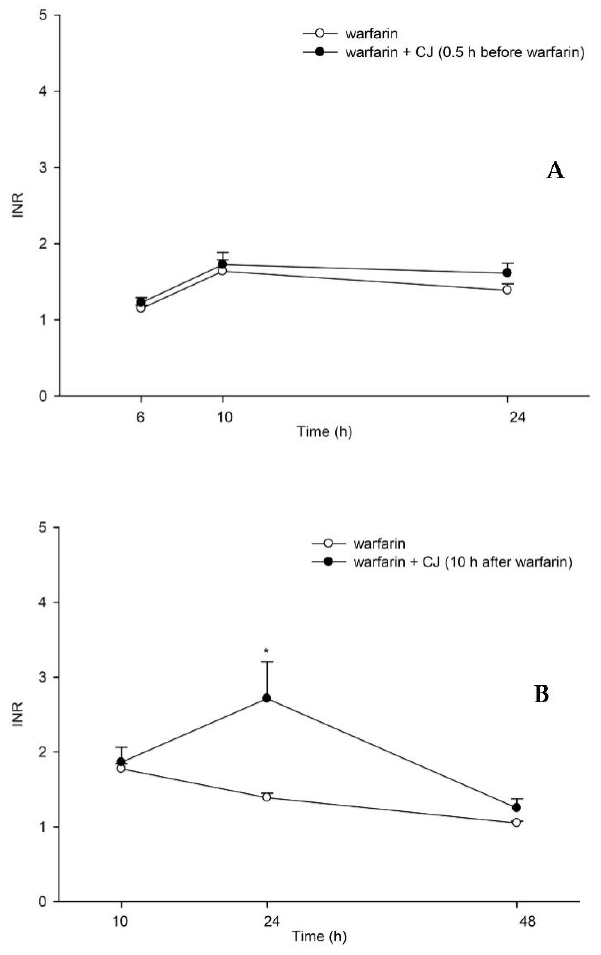
Figure 3. Mean ( ± S.E.) INR–time profiles after oral administration of ( ± ) warfarin (0.2 mg/kg) alone Figure 3. Mean (  S.E.) INR–time profiles after oral administration of (±) warfarin (0.2 mg/kg) alone and coadministration with cranberry juice (CJ, 5.0 g/kg) at 0.5 h before ( ± ) warfarin ( A ) and 10 h and coadministration with cranberry juice (CJ, 5.0 g/kg) at 0.5 h before (±) warfarin ( A ) and 10 h after ( ± ) warfarin ( B ) in rats. * p < after (±) warfarin ( B ) in rats. * p < 0.05.